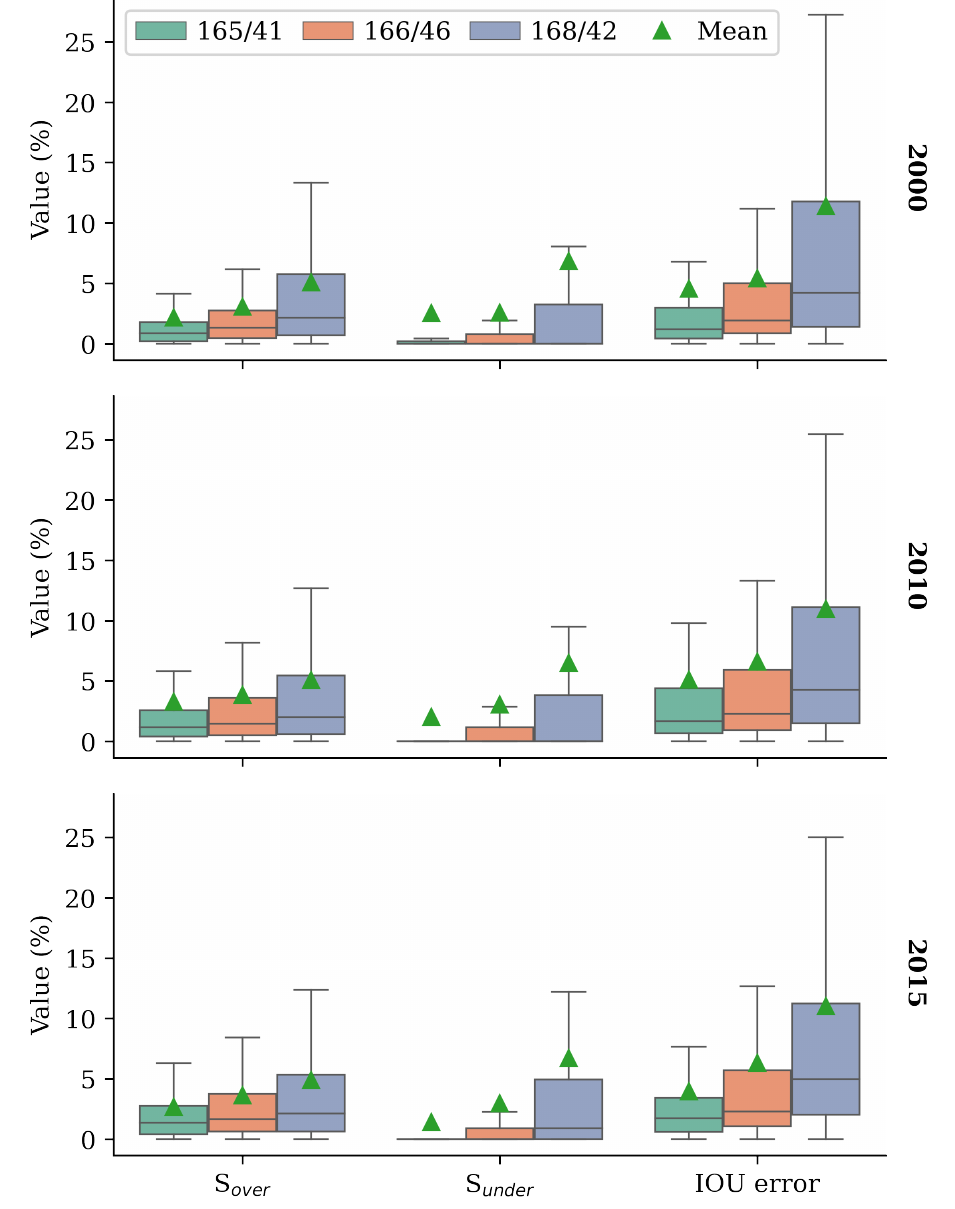
Figure 4. Boxplots of S over , S under , and IoU error for three evaluation tiles for all correctly detected fields (Table 3; row